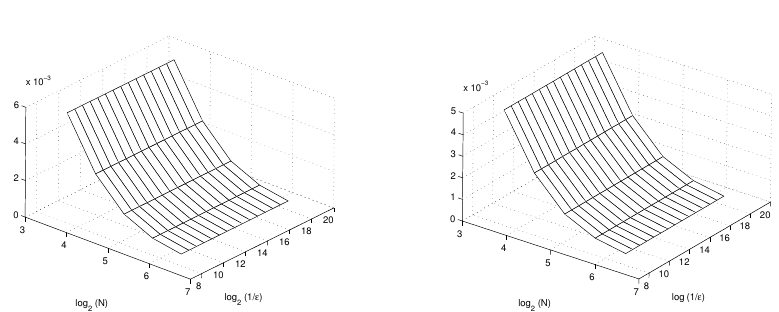
Figure 3. Surface plot of the maximum pointwise errors as a function of N and ε for the scaled discrete derivative components εD 0 Y 1 and εD 0 Y 2 using HDS - I for the Example 1.